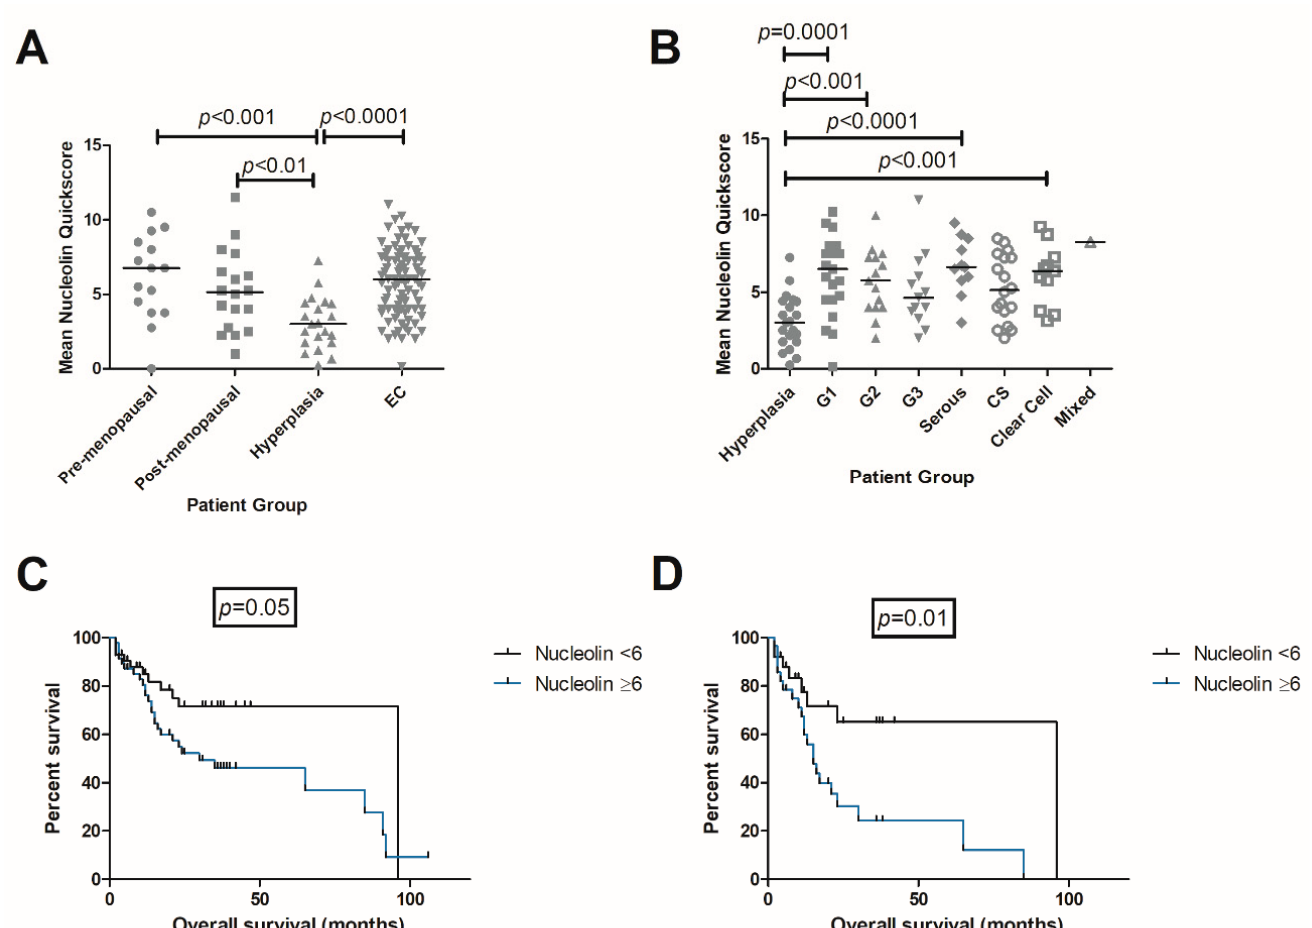
Figure 2. ( A ) Scatter plot showing NCL quickscore comparison across pre-menopausal ( n = 15), post-menopausal ( n = 18), EH ( n = 21) and EC ( n = 90) samples. Line indicates the median. ( B ) Scatter plot showing NCL quickscore comparison across EH ( n = 21), G1 ( n = 21), G2 ( n = 15), G3 ( n = 13), serous ( n = 11), carcinosarcoma ( n = 18), clear cell ( n = 11), and mixed ( n = 1) EC. Line indicates the median. ( C ) Kaplan–Meier survival curve showing effect of NCL expression on OS in EC. p = 0.05. ( D ) Kaplan–Meier survival curve showing effect of NCL expression on OS in HGEC. p = 0.01.